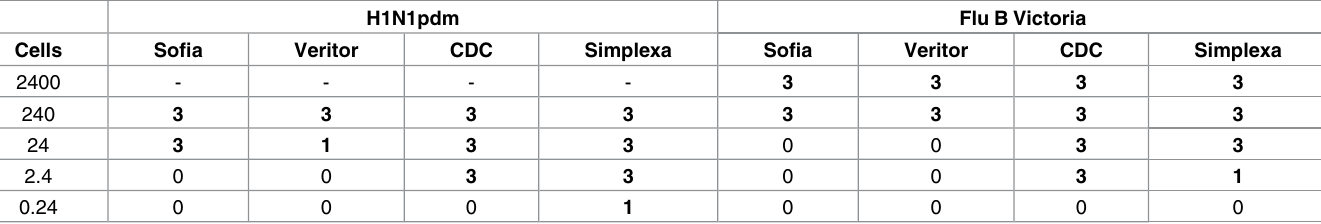
Table 7. Results of testing 10-fold serial dilutions of infected cells with each